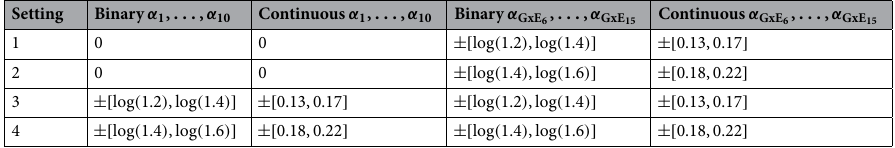
Table 1. Simulation settings for the second simulation scenario (see Eq. (5)) considering different effect sizes, different levels of statistical noise, and the presence or absence of main